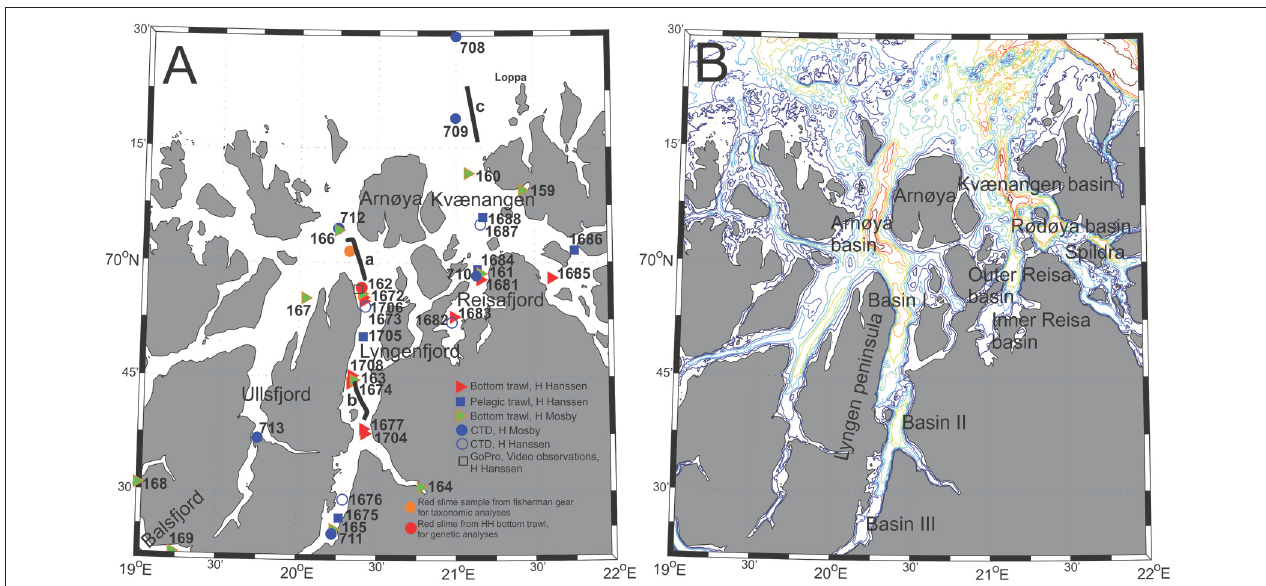
FIGURE 1 | (A) Overview of various types of sampling including trawl- and ctd-stations during the RV Håkon Mosby and RV Helmer Hanssen operations in Lyngenfjord and adjacent fjords during 6–9 October and 3–9 November 2015, respectively. a, b, and c: Acoustic transect as shown in Figures 9A–C respectively. (B) High resolution bottom topography with bottom contours, at 50m intervals from 50 to 400m depth. Names of deep-water basin and some other key features